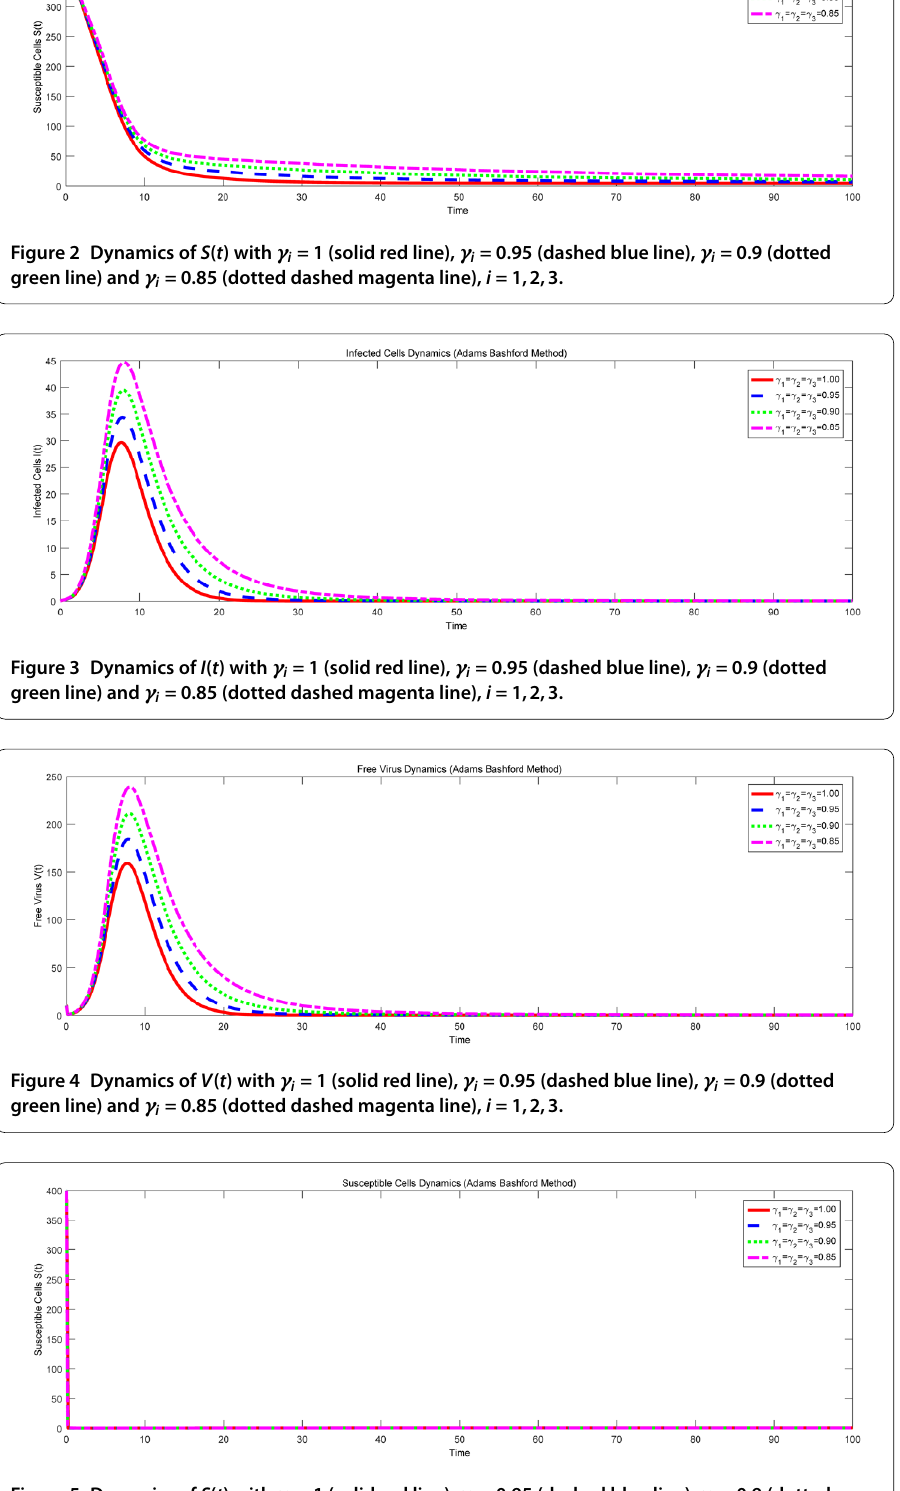
Figure 5 Dynamics of S ( t ) with γ i = 1 (solid red line), γ i = 0.95 (dashed blue line), γ i = 0.9 (dotted green line) and γ i = 0.85 (dotted dashed magenta line), i =